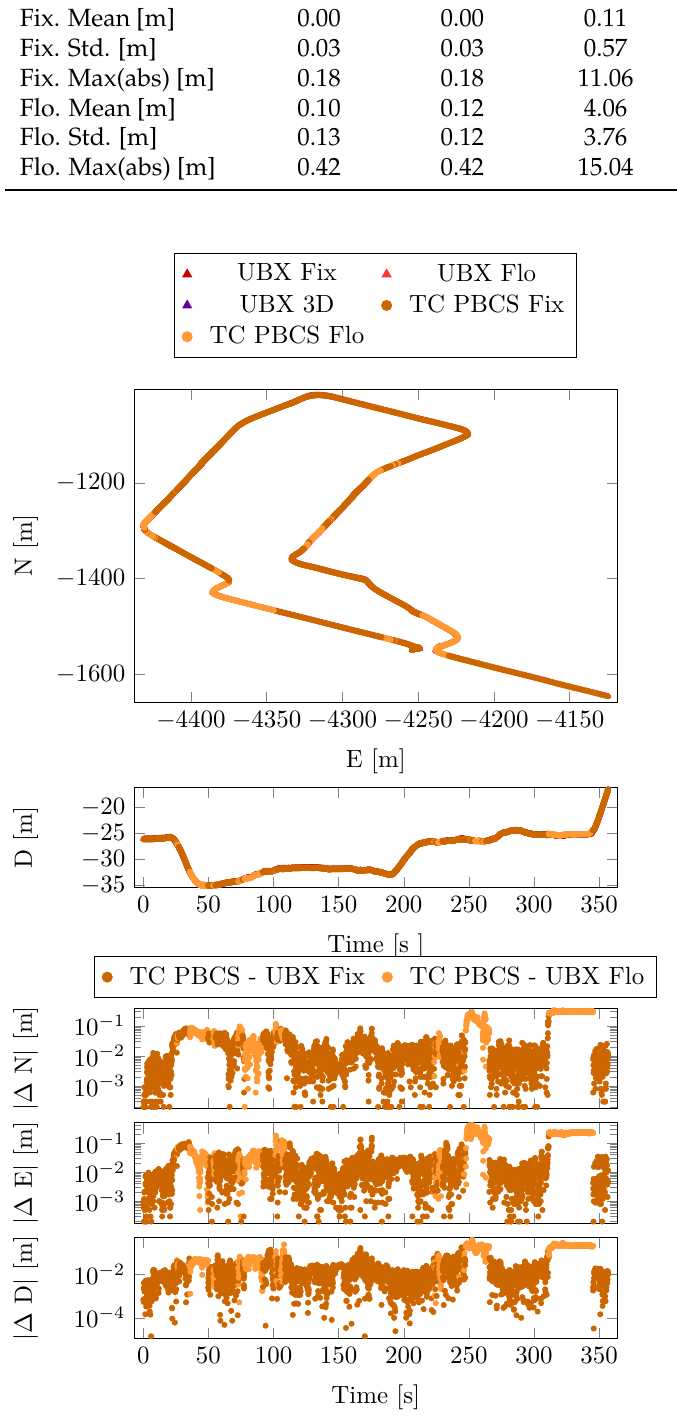
Figure 10. Position and position differences from the reference—Case Study 2. The velocity statistics (Table 8) confirm the struggle of the linear combination-based cycle slip methods. The higher horizontal, vertical standard deviations and maximum absolute values of the velocities indicate higher jumps in the position